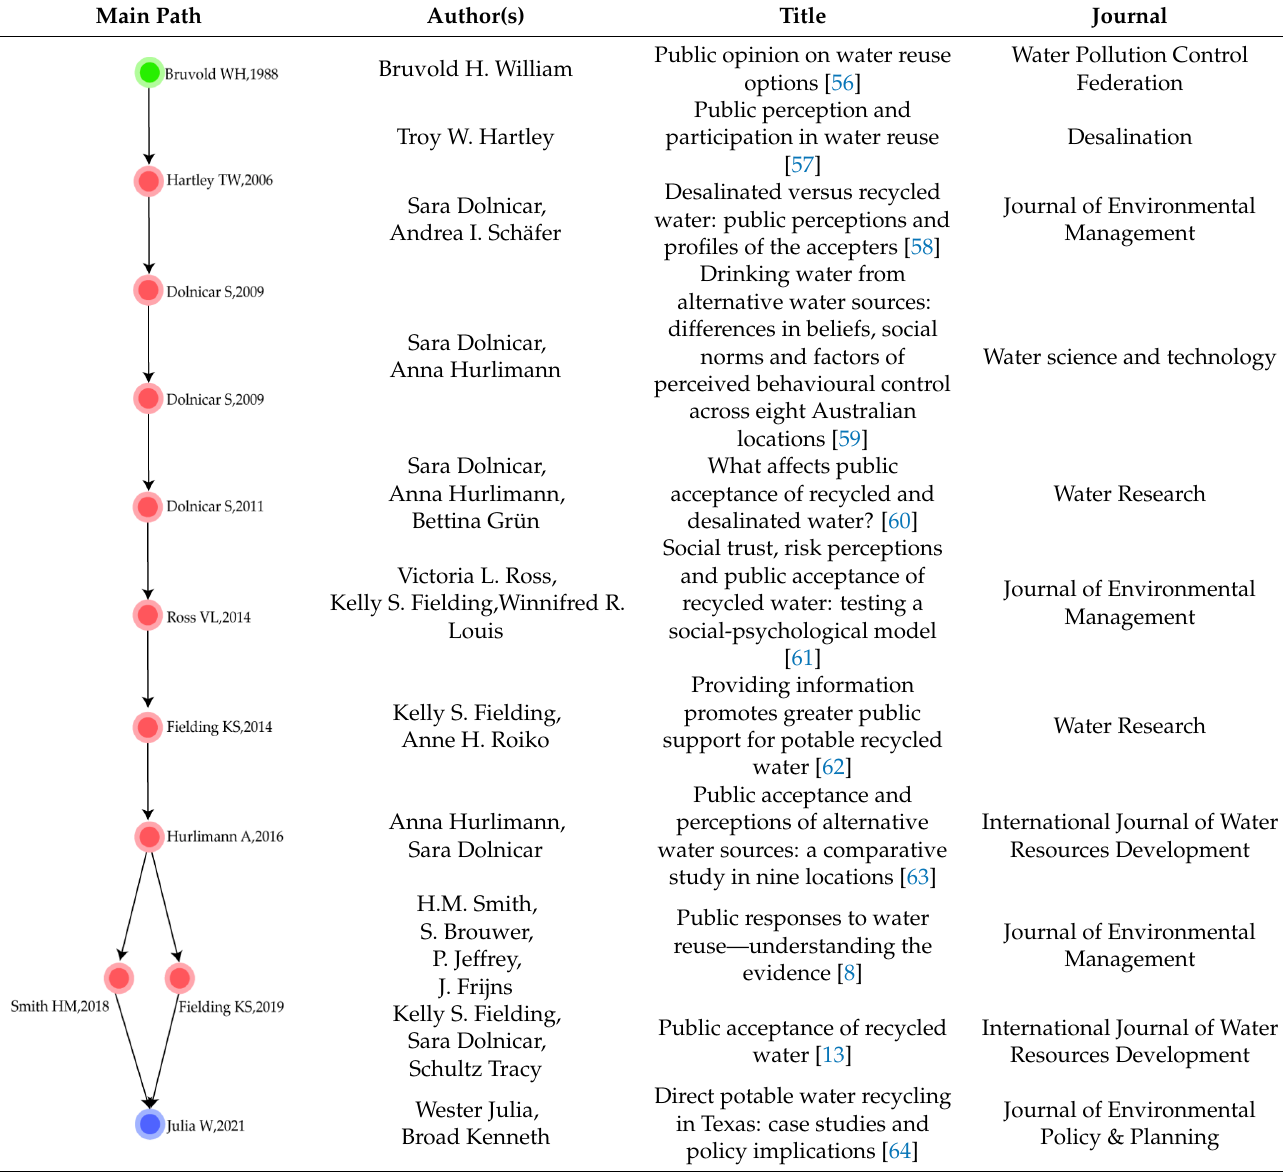
Table 1. The main path and key articles note